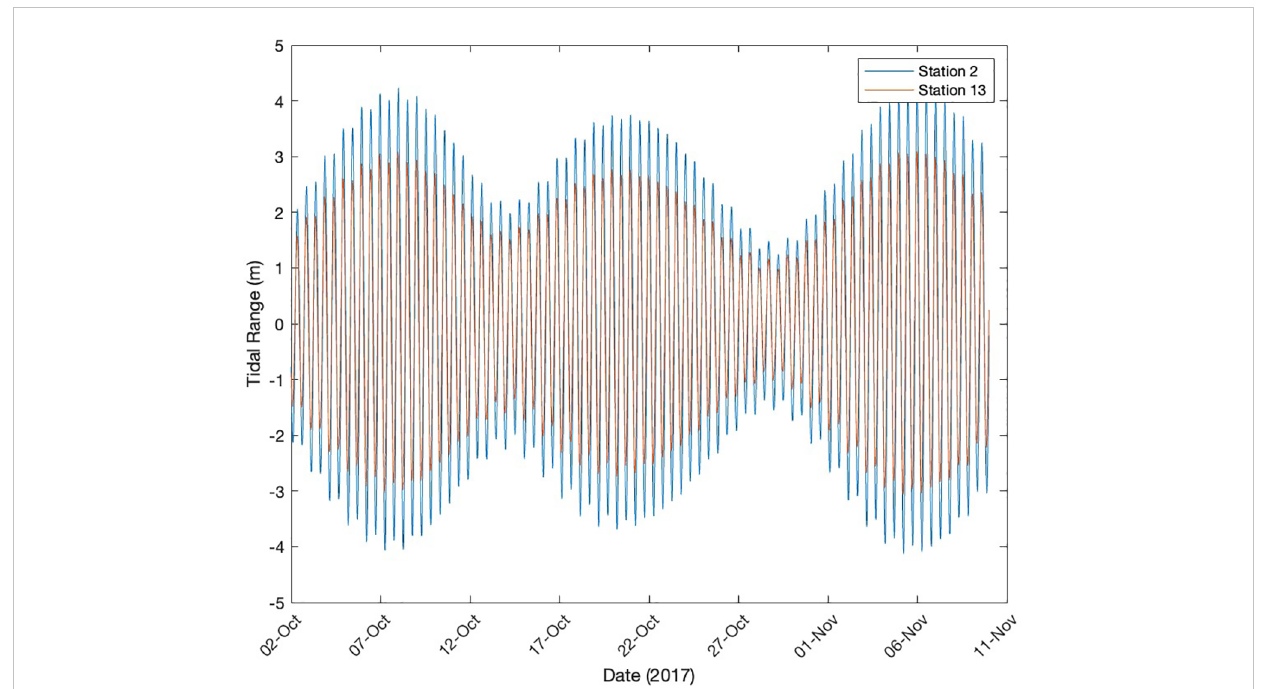
FIGURE 7 Time series of simulated tidal elevations for two contrasting sites across the study region, i.e. the locations that exhibited the highest (sample 2) and lowest (sample 13) tidal